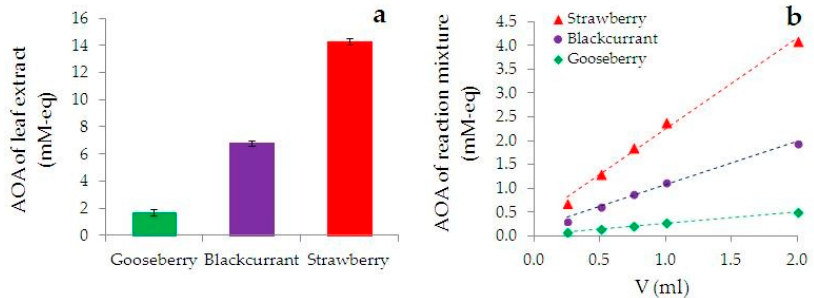
Figure 1. AOA of the leaf extracts ( a ) and the dependence AOA of the reaction mixture (HAuCl 4 + extract) on an aliquot of the introduced extract ( b ).